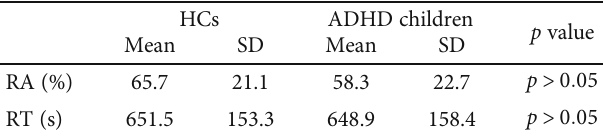
Figure 1: Experimental protocol of the visual P3 tasks used in this study. In each trial, a 250ms attention alert, a 500 ms preparation cue, a 500ms stimulus presentation, and a 1000 ms break were included. The upward-oriented triangles and down-oriented triangles with a thin cross in the center denoted standard and target stimuli, respectively. Only standard or target stimulus appeared once in one trial. Table 1: Behavioral